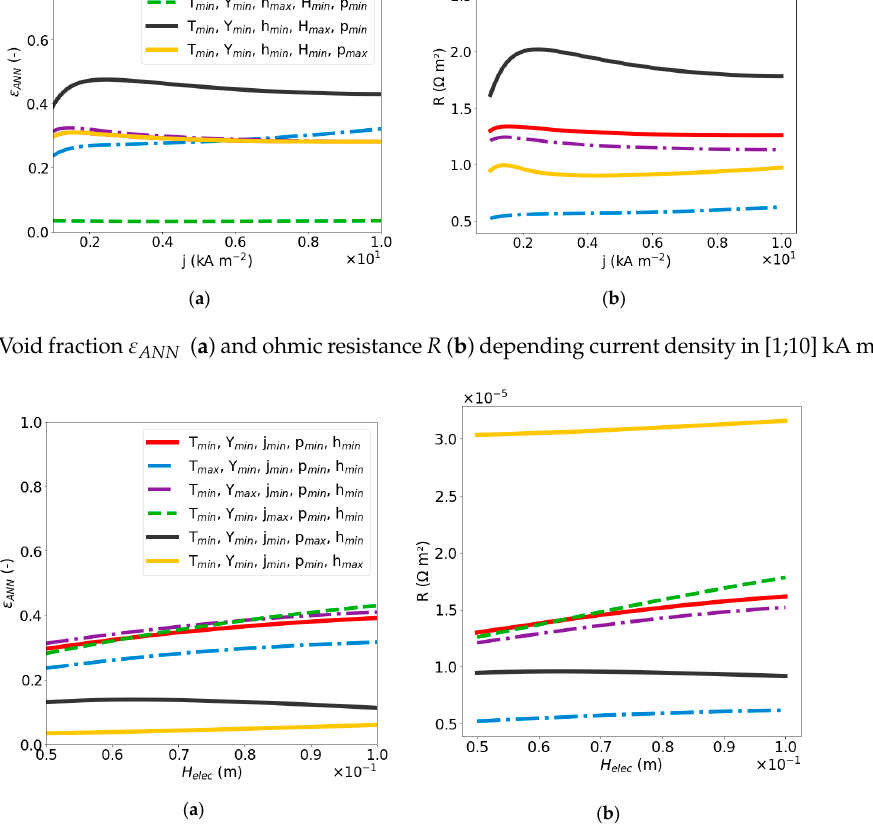
Figure 7. Void fraction ε ANN ( a ) and ohmic resistance R ( b ) depending on electrode height H elec